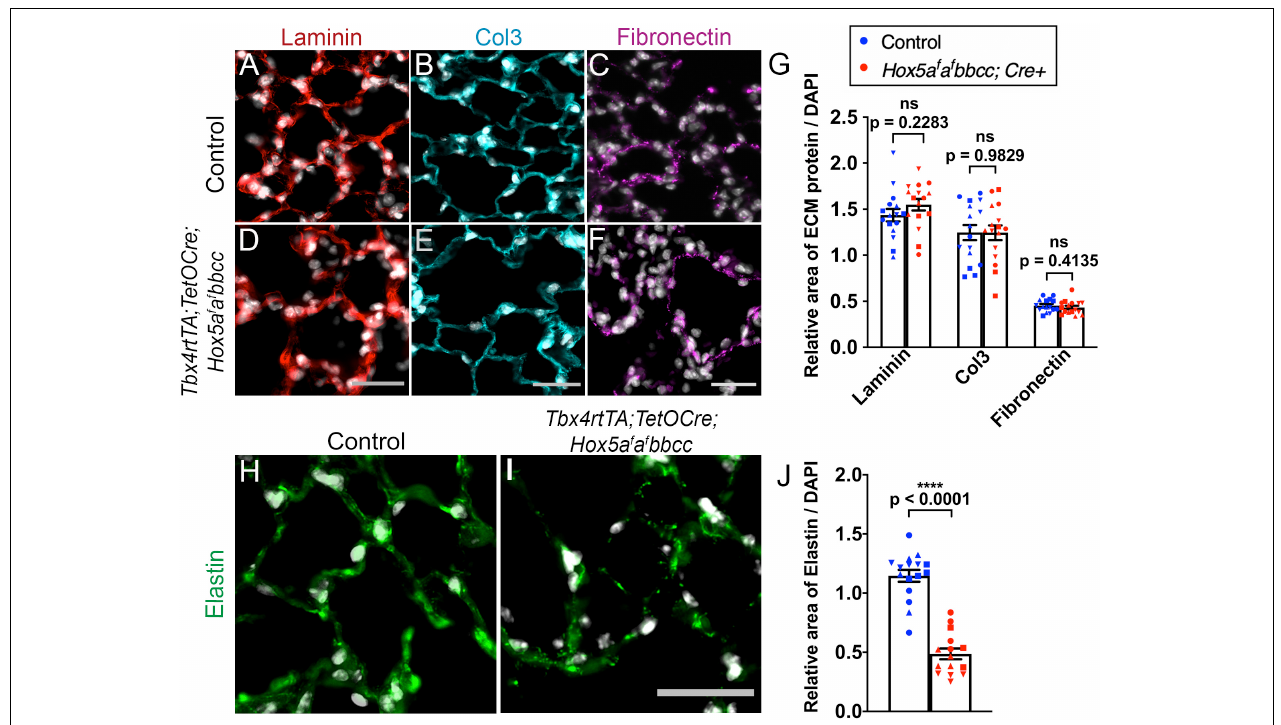
FIGURE 4 | The elastin network is disrupted in the Hox5 adult, conditional mutant lungs. Lung paraffin sections from control and Hox5 adult, conditional mutant mice stained with laminin (red, A,D ), collagen3 (cyan, B,E ), fibronectin (magenta, C,F ) and elastin (green, H,I ) with DAPI in gray in all. Quantifications of pixel intensity of laminin, collagen3, and fibronectin was normalized to pixel intensity of DAPI, and show no differences between controls and mutants (G) . The elastin network is disrupted, and the total elastin pixel intensity normalized to pixel intensity of DAPI per field image is significantly decreased in mutant lungs compared to control lungs (J) . Each shape represents an individual animal (ns, not significant). Scale bars: 25 µ m. P -values and statistical significance (**** P < 0.0001) were determined by an unpaired Student’s t